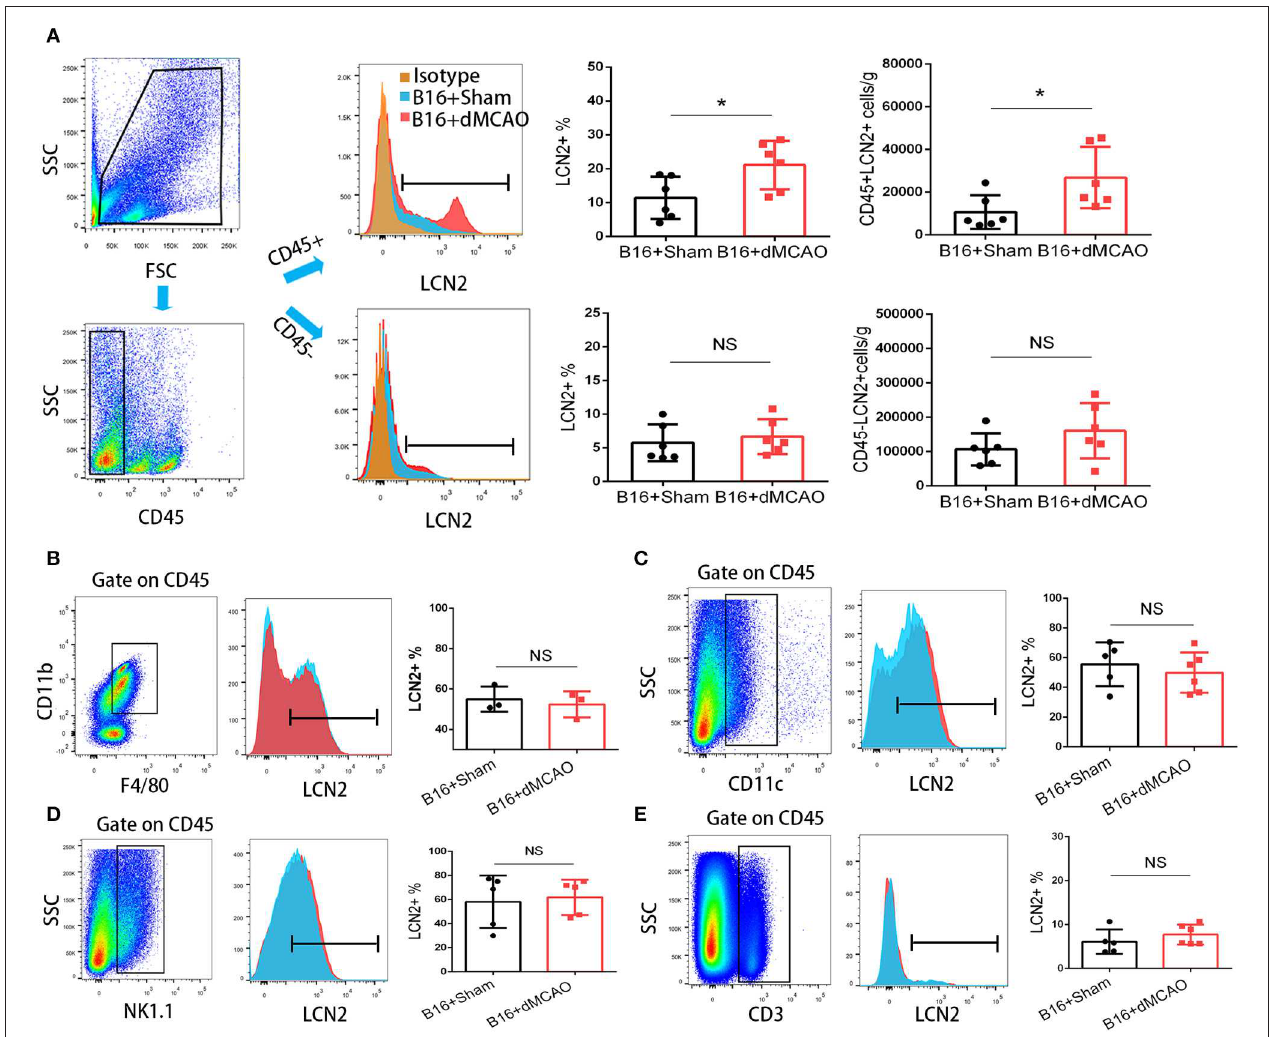
FIGURE 4 | Increased expression of LCN2 in CD45 + cells in the tumor of stroke mice. (A) Gating strategy of the flow cytometry of the tumor sample from cancer mice 3 days after stroke or sham surgery. Upper right panels showed increased LCN2 + CD45 + cells in the tumor of cancer mice after stroke. Lower panels revealed no significant difference in the LCN2 + CD45 − cells (cancer cells) in the tumor of stroke mice. (B,C) LCN2 expression in CD11b + CD45 + F4/80 + cells (tumor associated macrophages, TAMs) and CD11c cells (Dendritic cells) in the tumor. (D,E) LCN2 expression in NK1.1 cells (NK cells) and CD3 + cells (T cells) in the tumor ( n = 3–6/group. * P ≤